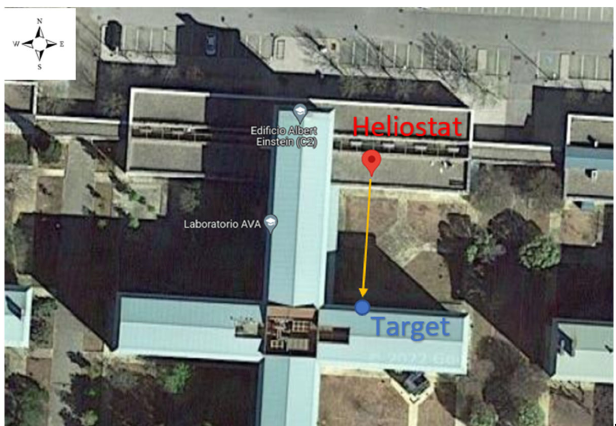
Figure 12. Case study: Albert Einstein building (C2), Rabanales campus of the University of Cordoba (Spain, latitude: 37.85° N; longitude: 4.18° W).